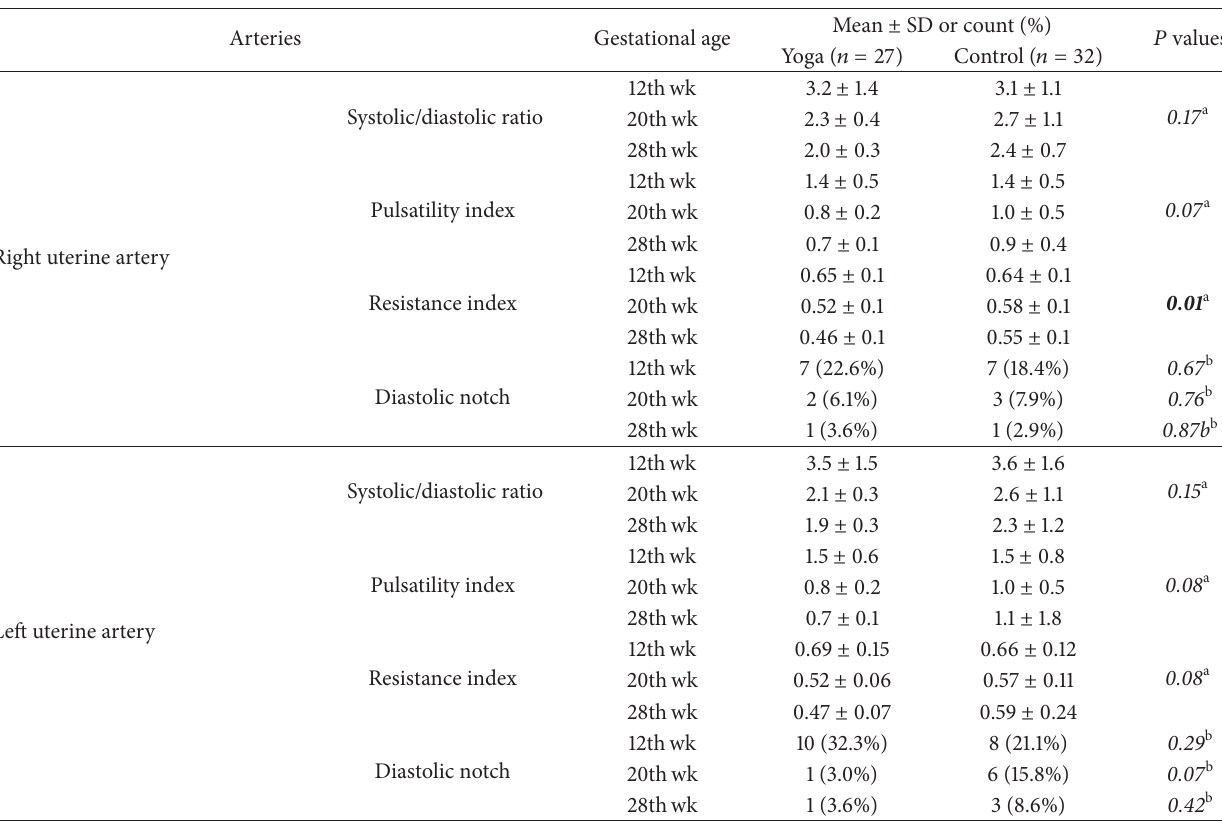
Table 4: Measures of uteroplacental circulation between